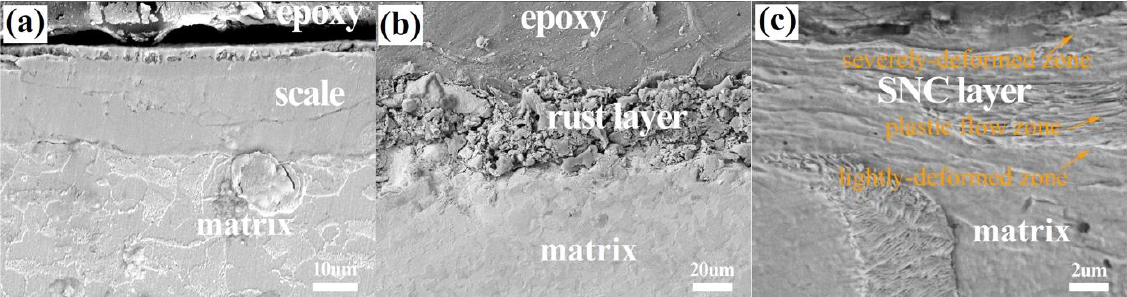
Figure 2. SEM microstructure of the rebar: ( a ) scaled rebar, ( b ) rusted rebar, and ( c ) SNC rebar. The XRD patterns of the three kinds of rebar and the rebar matrix are presented in Figure 3. There are three main diffraction peaks belonging to the rebar matrix, which are related to the (110), (200), (211) diffraction planes, according to PDF#34-0396. The diffraction peak is observed at a 2 𝜃 value of 45.2°, corresponding to the (202) diffraction plane, according to PDF#50-1275. Considering the main alloy elements of the rebar, it can be concluded that the phase structure of the rebar matrix mainly consists of Fe-Cr solid solution with a body-centered cubic structure. For the rusted rebar, the peak at the 2 𝜃 value of 45.2° corresponds to Fe 2 O 3 in the rust layer. In Figure 3, the diffraction peak at 2 𝜃 = 45.2° obtained for the scaled rebar can be inferred to correspond to Fe 2 O 3 in the mill scale. The SNC rebar has the same diffraction peak as that in the rebar matrix, which does not show a diffraction peak at a 2 𝜃 value of 45.2°, indicating that the rust layer on the original surface has been completely removed.